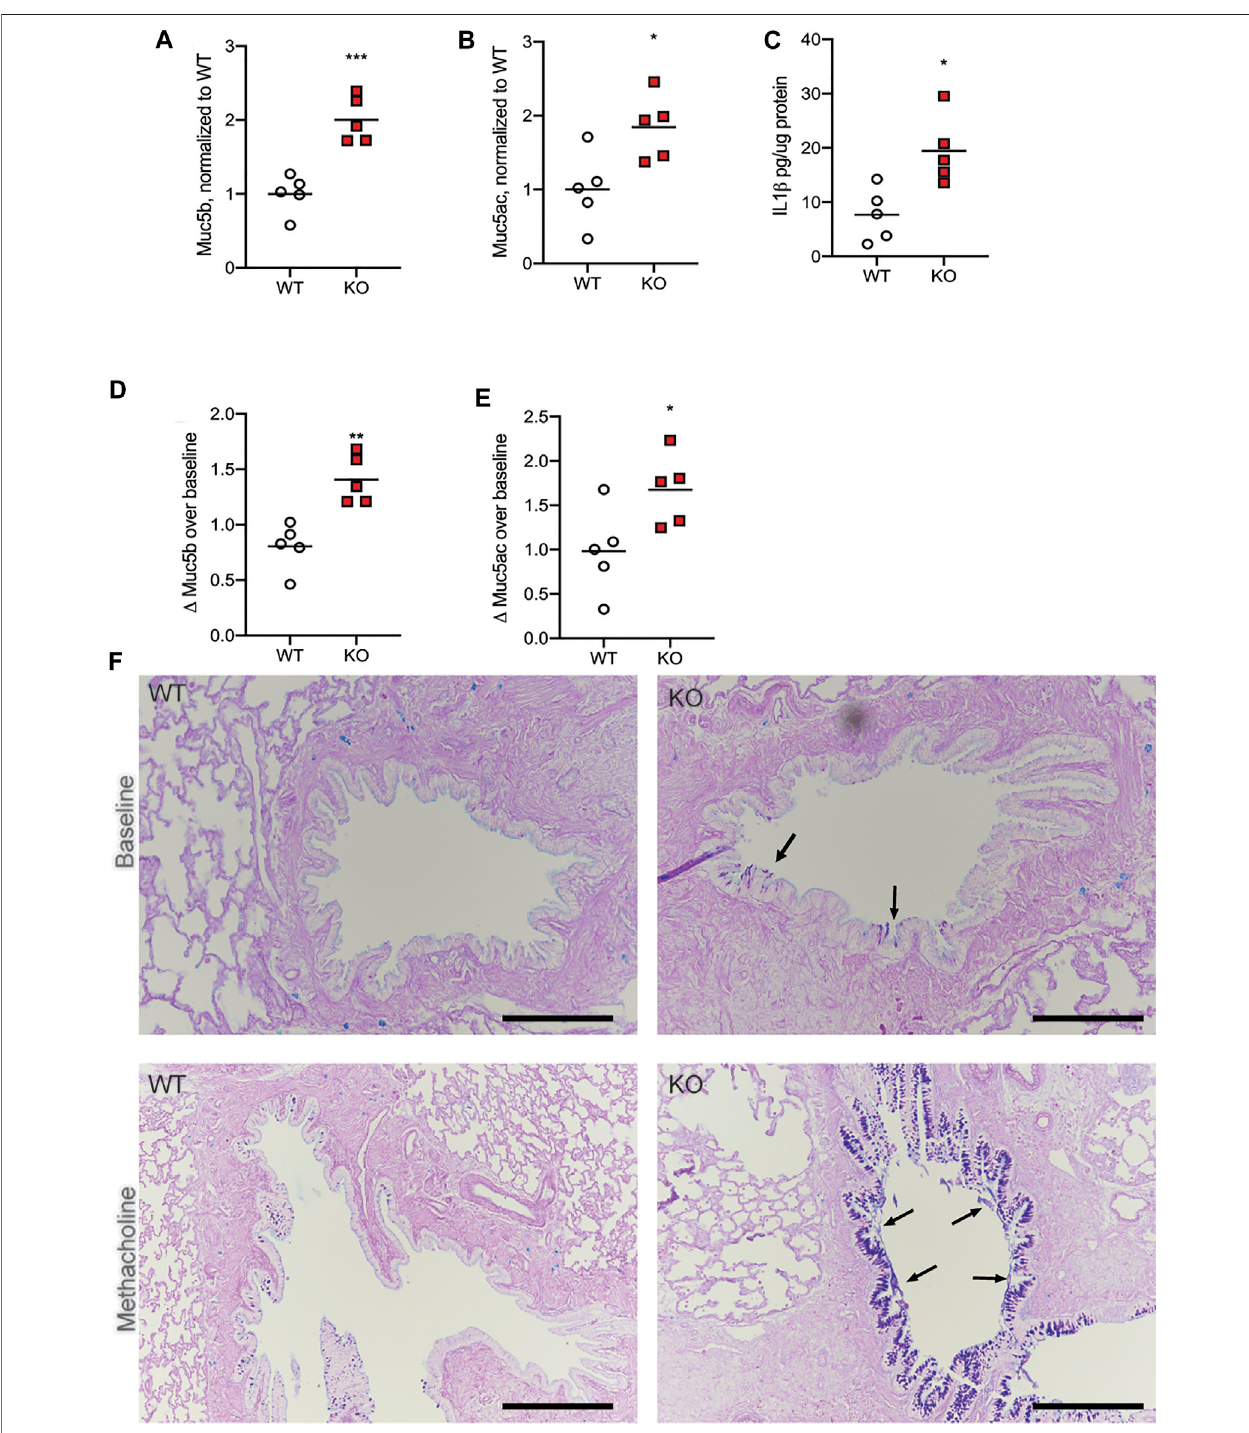
FIGURE2| Methacholine administration increasesmucin in theBALF. WTand KOrats at 6 months ofage received methacholinesubcutaneouslyfor 7 days, with BALFanalysisonday8. (A) Muc5b and (B) Muc5acintheBALFweredetected via dotblot, andKOnormalized toWTvalues. (C) IL-1 β concentrationsintheBALFwere detected via ELISA. (D) Muc5b and (E) Muc5ac in the BALF were compared to the mucin detection from Figure 1 to calculate a Δ over baseline. Lines on each graph represent the mean. Data were analyzed via student ’ s t-test. * p < 0.05, ** p < 0.01, *** p < 0.001. (F) Representative histologic images with AB-PAS staining are shown from three separate experiments from WT and KO at baseline as well as WT vs. KO after methacholine treatment. Black arrows indicate mucus detected on the surface of the epithelium. Black scale bar = 200 μ m.